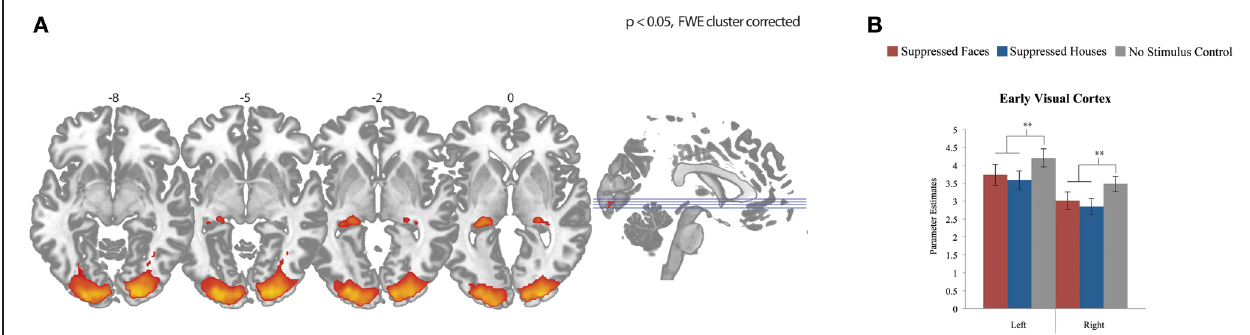
FIGURE 2 | Effects across all conditions. (A) Whole brain fMRI response to fearful faces, houses, and control compared to resting baseline. Data show effects in bilateral lateral geniculate nucleus and early visual cortex, FWE cluster corrected for multiple comparisons, p < 0 . 05. (B) fMRI response in early visual cortex for each condition, plotted individually by